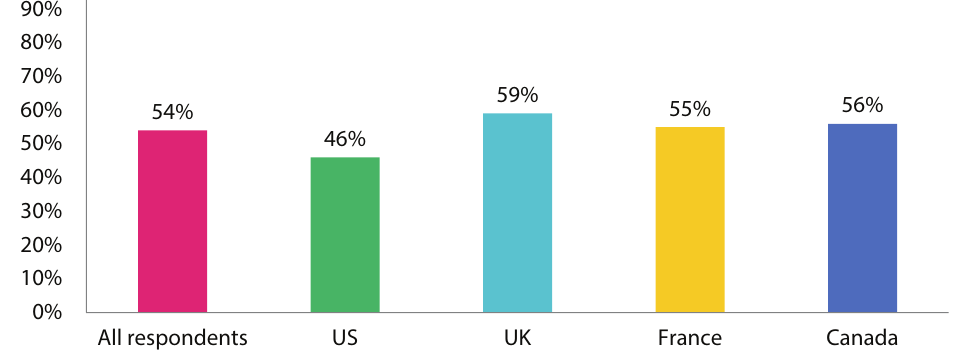
Figure 2. Self‐assessed exposure to misinformation about